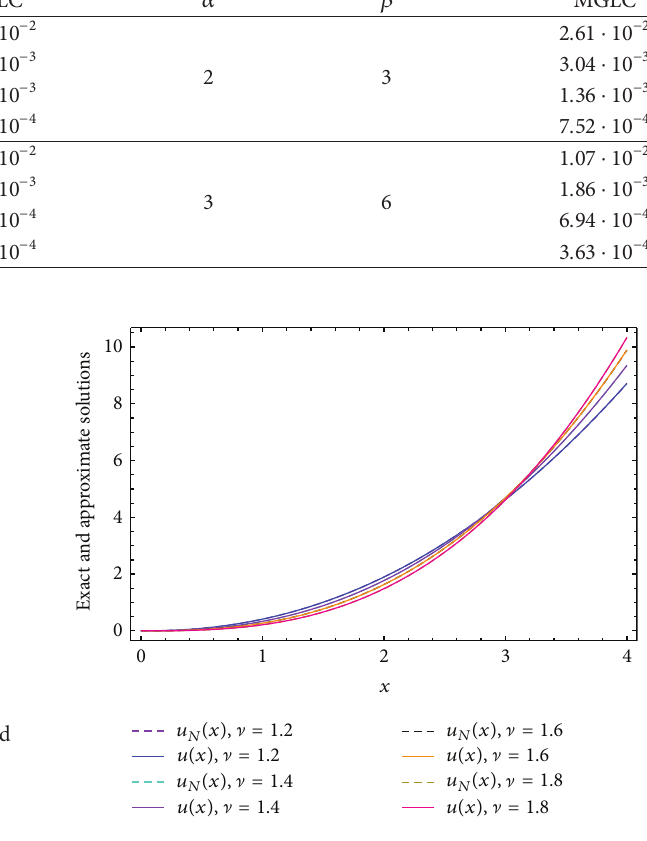
Figure 13: Comparing the exact and approximate solutions at 𝑁 = 16 , 𝛼 = 0 , 𝛽 = 1 , and ] = 1.2 , 1.4, 1.6, and